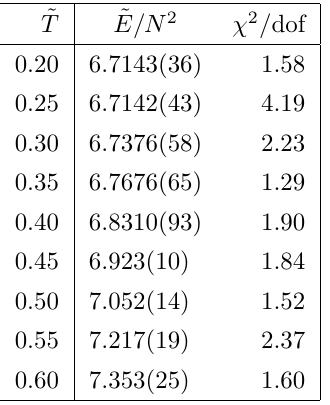
Table 4. Continuum large- N values for the internal energy of the bosonic ungauged theory. Re- duced (cid:31) 2 values are also reported. Extrapolations at ~ T = 0 : 25 have a larger-then-usual (cid:31) 2 = dof > 4.